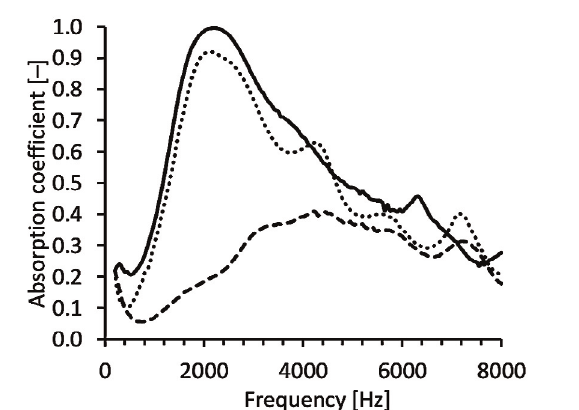
Fig. 9. Absorption coefficient for materials A (dotted line), B (solid line) and C (dashed line) with distance X1 set to 15 mm.